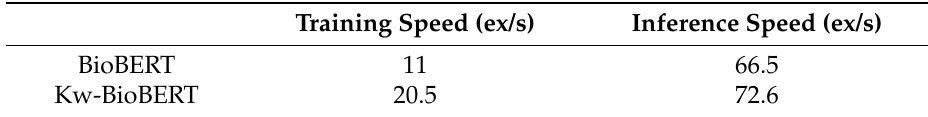
Table 7. Overhead comparison between Kw-BioBERT and